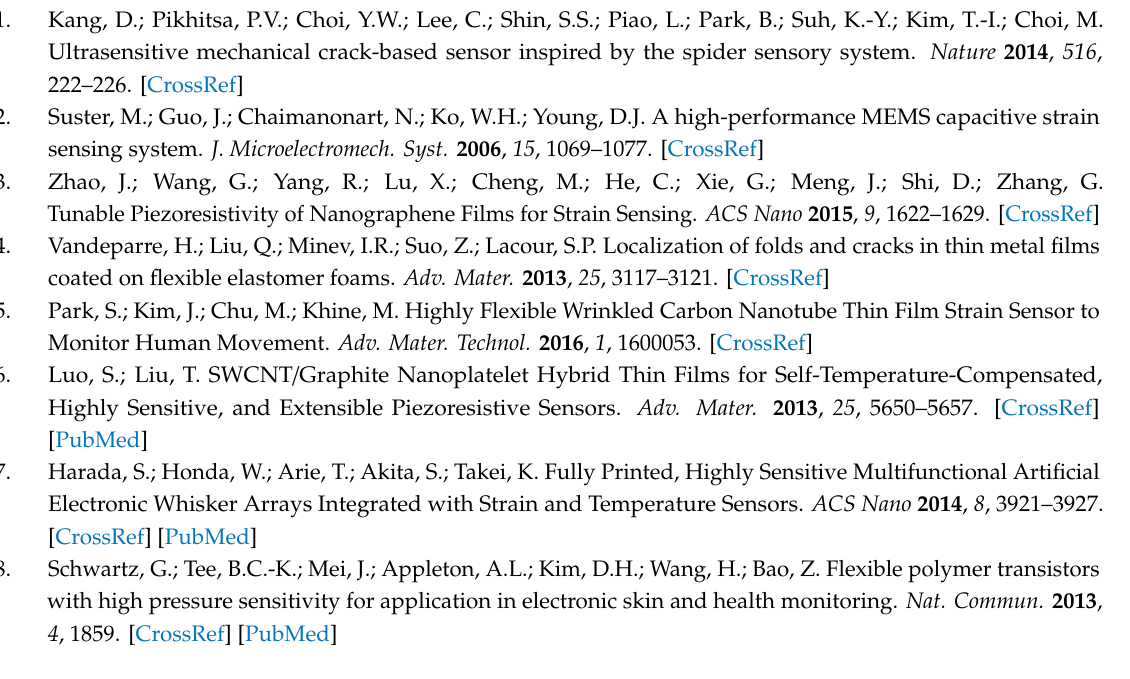
Figure S1: Resistance of a carbon ink sensor as a function of the temperature, Figure S2: Stress-strain response shows elastic